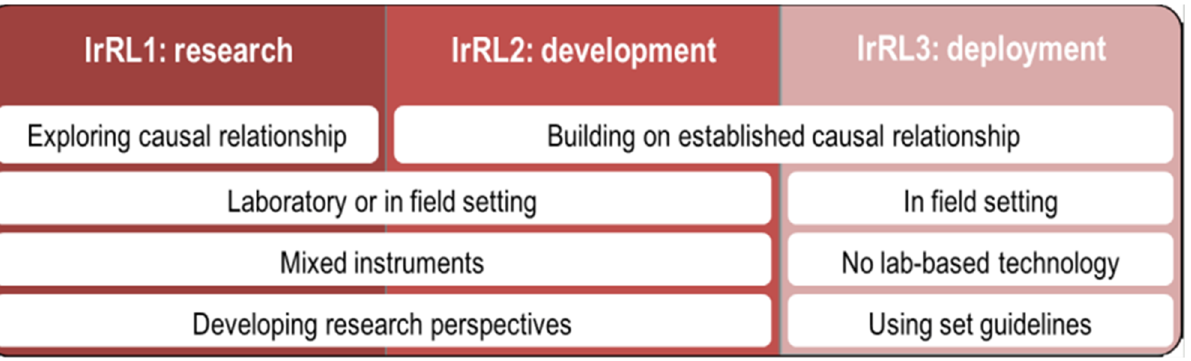
Figure 1. The injury-research readiness level classification model, where different classes of research maturity (IrRL1-3, in columns) are mapped against the following feature domains (rows): knowledge of causal relationship, experimental settings, testing technology, and normative guidelines.